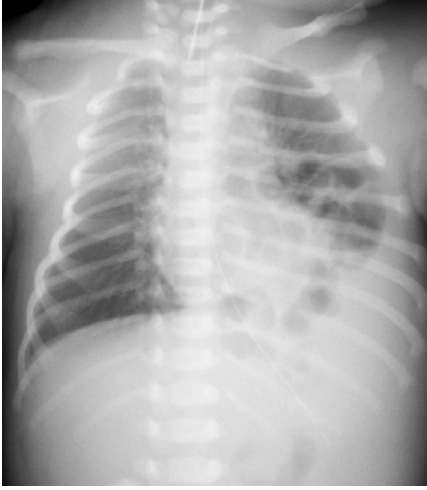
Fig. 5 Chest radiograph in case 2. Chest radiograph shows left diaphragmatic